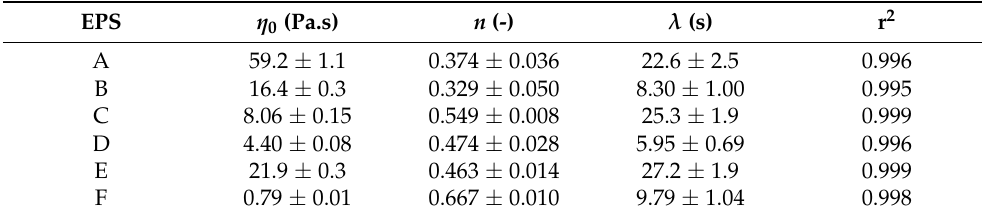
Table 2. Carreau model parameters ( η 0, zero-shear rate viscosity; n , viscosity exponent; λ , time constant) estimated for the filmogenic solutions prepared with the different EPSs produced by Alteromonas strains isolated from French